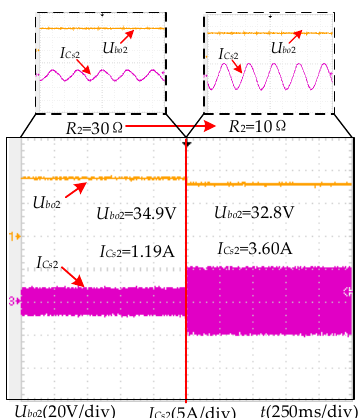
Figure 15. The variation of output voltage and input current with the load.